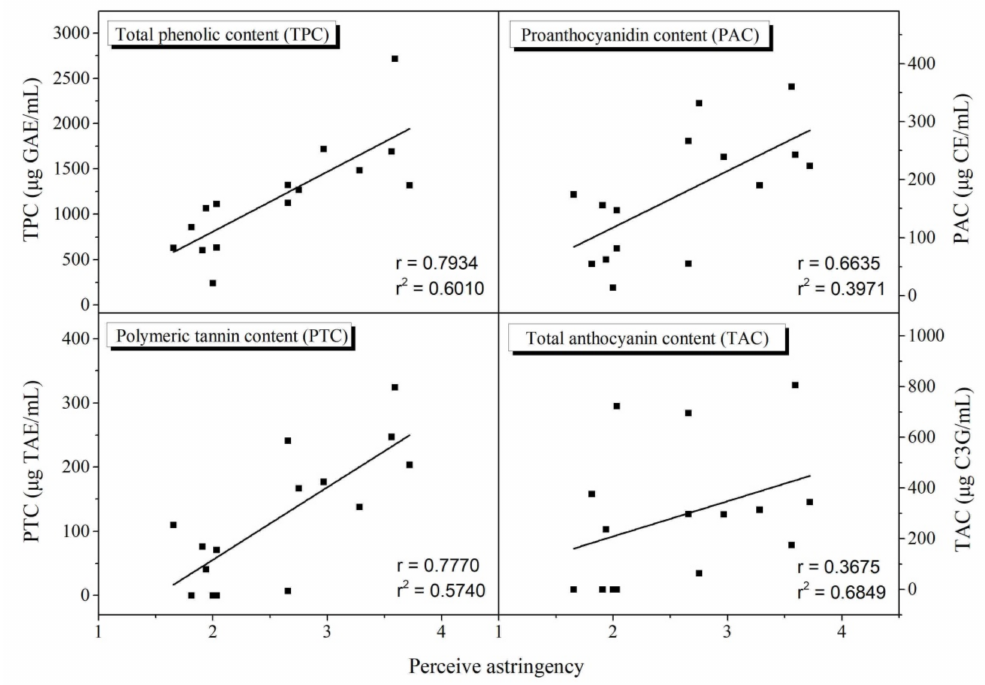
Figure 2. Plots of the correlations between perceived astringency and the TPC, the PAC, the PTC and the